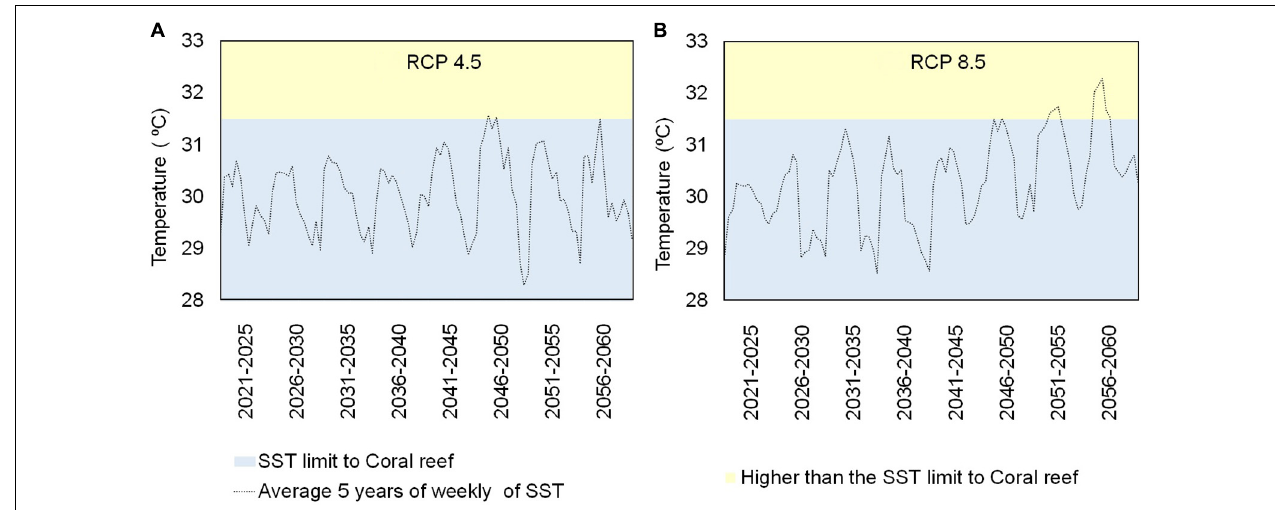
FIGURE 7 | Variation of 5 years average of weekly sea surface temperature in June, July, and August for the period 2021–2065 in Cu Lao Cham. The blue region shows the temperature range in which coral are able to